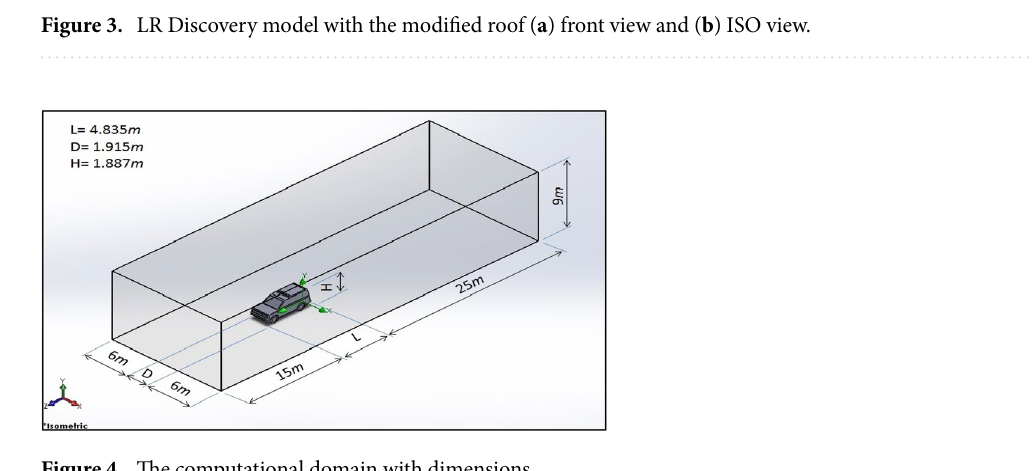
Figure 4. The computational domain with